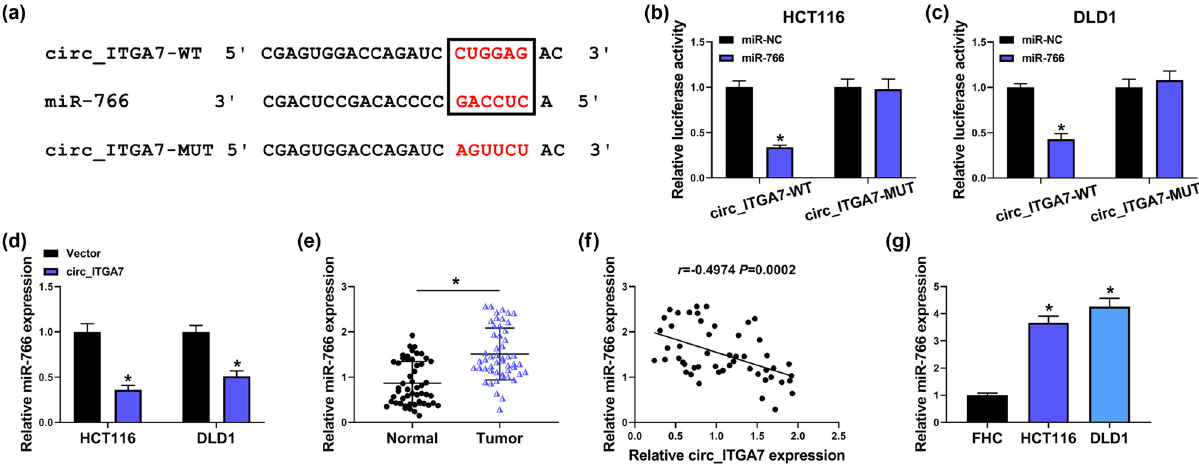
Figure 3: miR - 766 is a target of circ_ITGA7. ( a ) Schematic diagram representing the predicted binding sites for miR - 766 in circ_ITGA7. ( b and c ) Dual - luciferase activity assay for the detection of the relative luciferase activity of wild and mutated circ_ITGA7 reporter after miR - 766 up - regulation in HCT116 and DLD1 cells. ( d ) qRT - PCR analysis of miR - 766 expression in HCT116 and DLD1 cells transfected with Vector or circ_ITGA7. ( e ) qRT - PCR analysis of miR - 766 expression in CRC tissues and matched normal tissues. ( f ) Pearson ’ s correlation coe ffi cient analysis for the correlation between miR - 766 in circ_ITGA7 expression in CRC tissues. ( g ) qRT - PCR analysis of miR - 766 expression in CRC cell lines and normal FHC cells. * P <